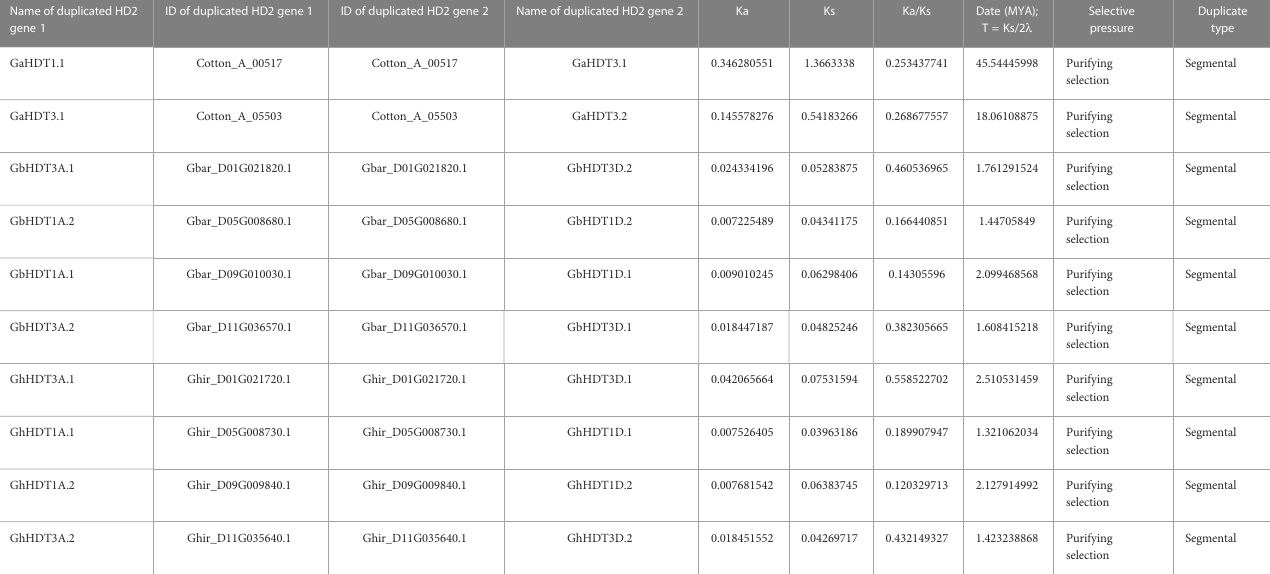
TABLE 4 Ka/Ks ratios and dates of duplication for duplicated HD2 genes in G. arboreum, G. hirsutum, and G. barbadense.